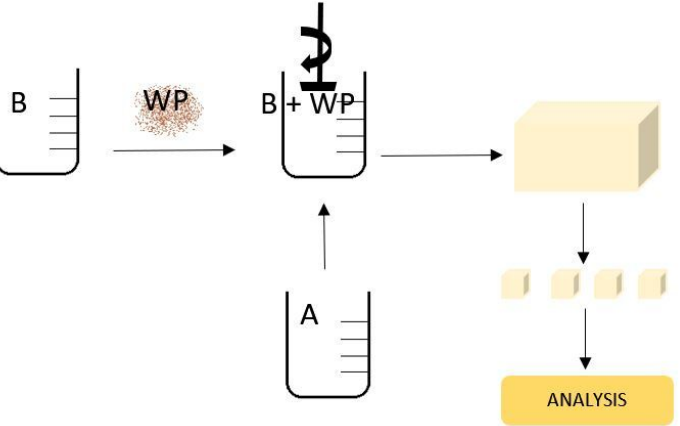
Figure 3. Scheme of PUR manufacturing (A—polyol; B—isocyanate; WP—wood particle s ).